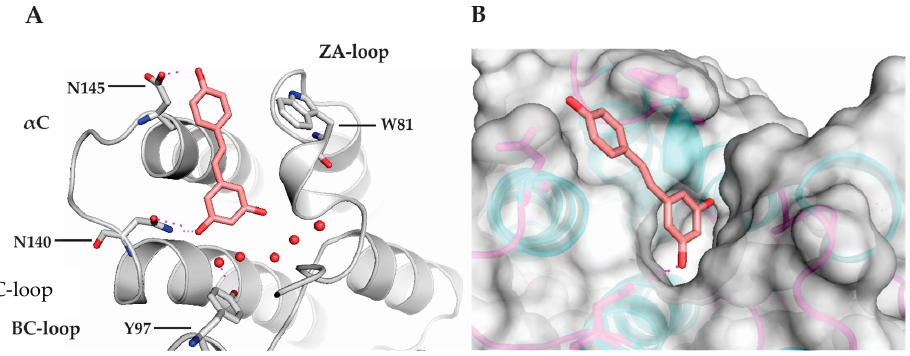
Figure 2. Molecular docking of BRD4(1) and RSV. A , hydrogens bond formed with Asn140 in the Kac binding site from BC-loop and Asn145 from α C. B , RSV interactions into Kac binding site and open ZA-loop pockets in surface mode. W81: Tryptofan 81; Y97: Tyrosine 97; N140: Asparagin 140; N145: Asparagine 145.